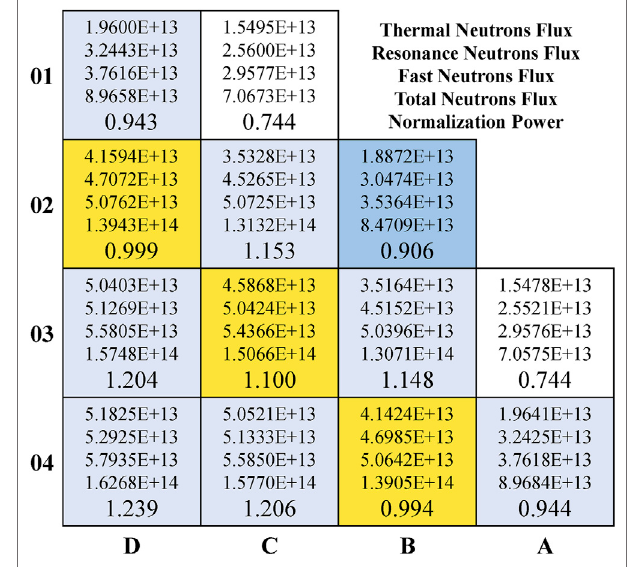
FIGURE 10 | Three-dimensional temperature distribution for the single- channel model of D-4